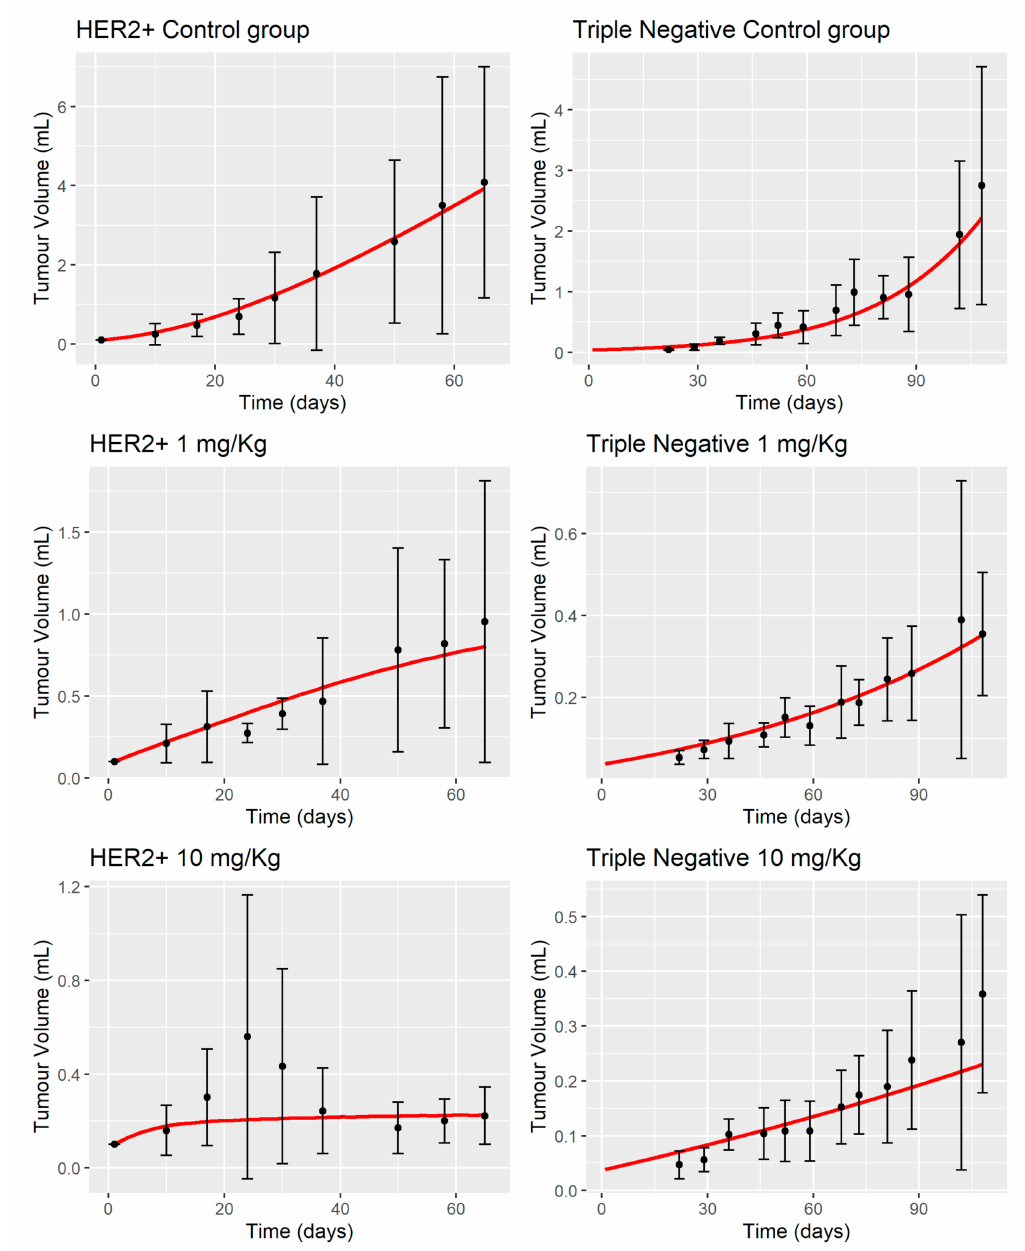
Figure 4. Tumor growth model (perturbed and unperturbed) for the HER2 + and Triple Negative cell lines. Red line represents the typical simulated individual. Black dots represent the mean of all observations at the sample time with the corresponding 95% Confidence Interval (vertical